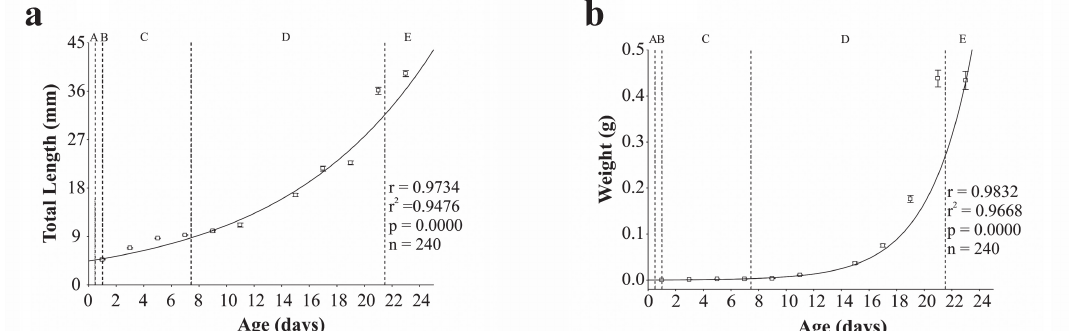
Fig. 5. Pseudoplatystoma reticulatum growth during larval and juvenile development, from hatching to the 24 th day of life. Larval stages: A: yolk-sac larva, B = preflexion, C = flexion, and D = postflexion; and E = juvenile. (a) Relationship between total length and age, and (b) relationship between weight and